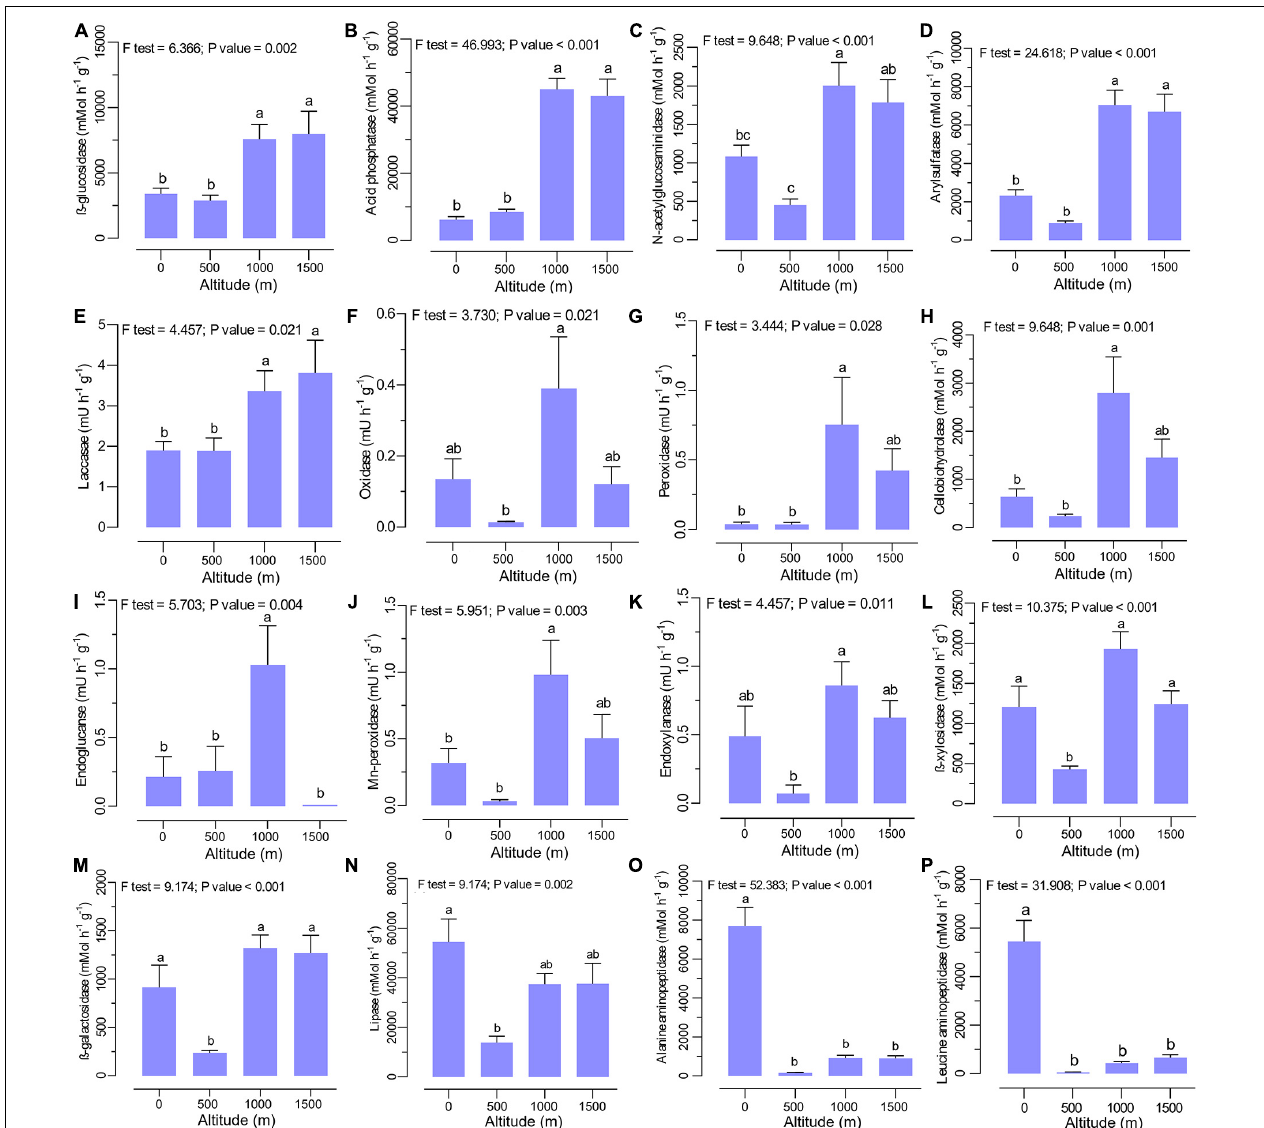
FIGURE 3 | Soil extracellular enzyme activities such as (A) β -glucosidase, (B) acid phosphatase, (C) N-acetylglucosaminidase, (D) arylsulfatase, (E) laccase, (F) oxidase, (G) peroxidase, (H) cellobiohydrolase, (I) endoglucanase, (J) Mn-peroxidase, (K) endoxylanase, (L) β -xylosidase, (M) β -galactosidase, (N) lipase, (O) alanine aminopeptidase, and (P) leucine aminopeptidase at various altitudes. Different letters indicate a significant difference along the altitudinal gradient (ANOVA and Tukey HSD test; p <